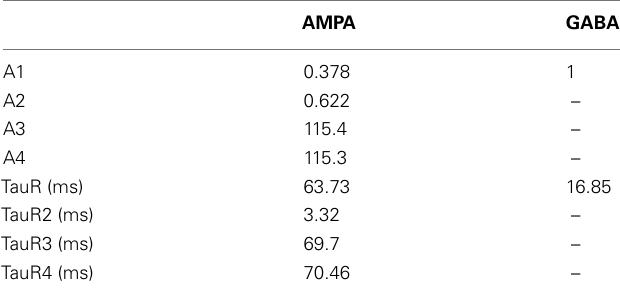
TableA4 |AMPA and GABA depression equation constants